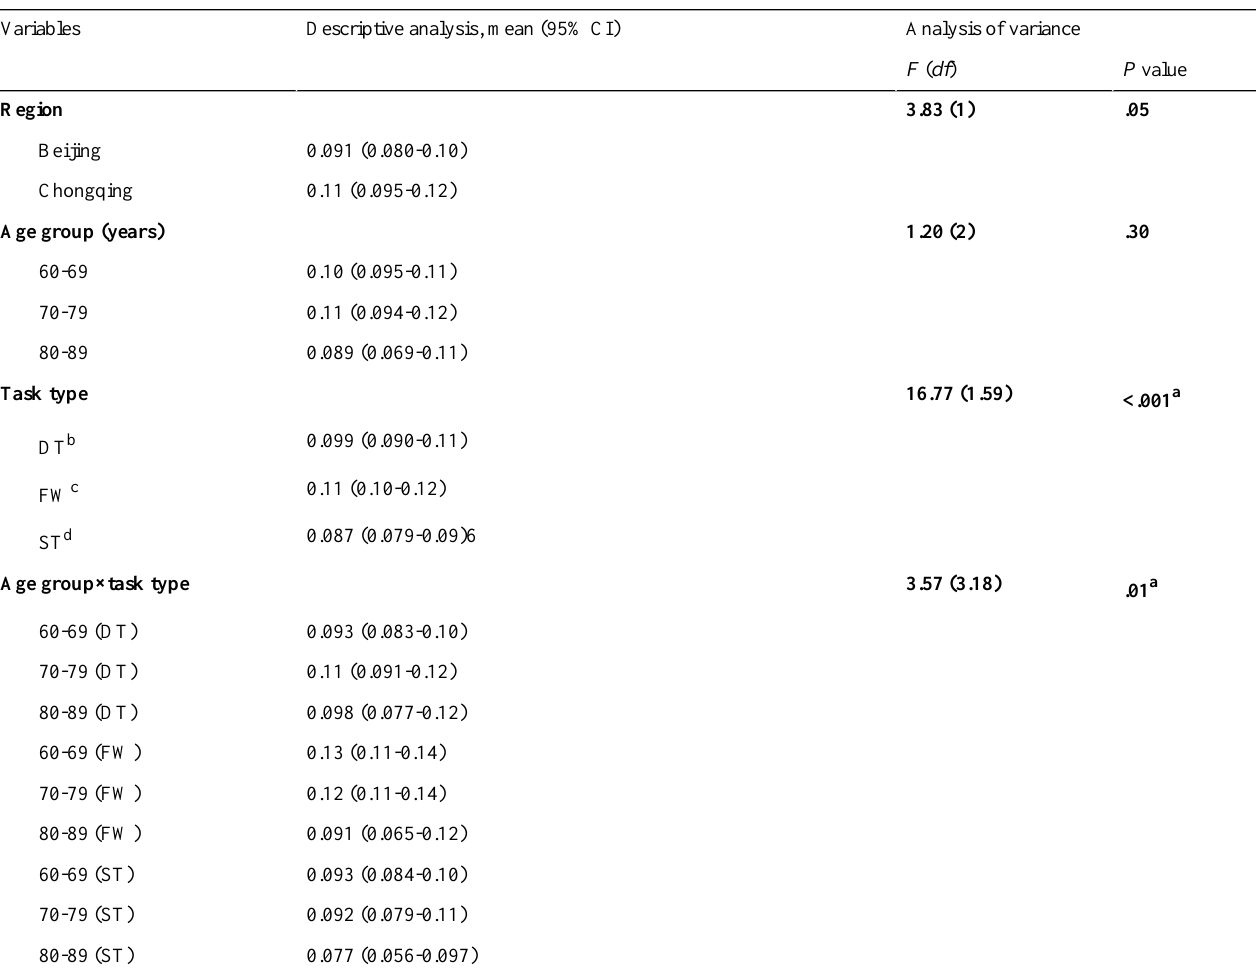
Table 4. Statistics for step variability.